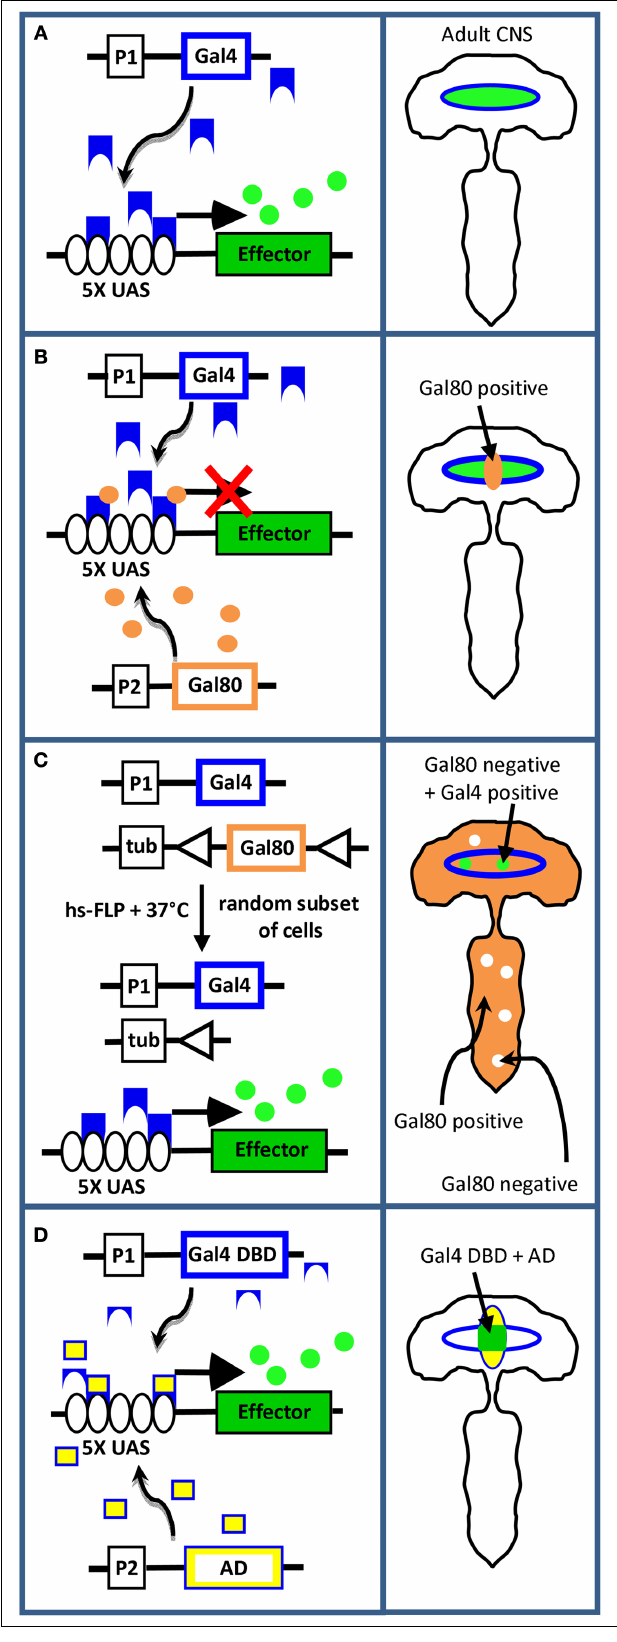
gene lies downstream of the promoter/enhancer element, P1, which dictates its pattern of expression. The effector transgene lies downstream of fi ve Gal4 binding sites (i.e. “UAS,” black ovals). In fl ies bearing both constructs, neurons that express Gal4 protein (blue shapes) also express the effector protein (green circles). Right panel: schematic of the fl y CNS depicting coincident expression of Gal4 (blue outline) and effector (green oval). (B) Subtractive restriction of effector gene expression using Gal80. Left panel: In cells that express the gene encoding Gal80 (brown outline) under the control of the promoter/enhancer P2, Gal80 protein (brown circles) will inhibit Gal4 by binding to its transcription activation domain and thus block effector gene expression (red X). Right panel: if P1 and P2 have overlapping expression patterns, Gal4 activity, and therefore effector expression, is eliminated in the region of overlap (i.e. in Gal80 positive cells, brown). (C) Random restriction using the “fl p-out Gal80” system. Left panel: if the Gal80 transgene is placed downstream of the ubiquitously active tubulin promoter (tub) and is fl anked by sites (triangles) that permit excision by heat-shock induced fl p-recombinase activity, the Gal80 gene will be deleted in random subsets of cells in animals subjected to heat shock. Only cells that express Gal4, but not Gal80, will also express the effector gene. Right panel: Effector expression (green) is limited to cells within the Gal4 expression pattern (blue outline) that lack Gal80 expression. (D) Combinatorial restriction using Split Gal4. Left panel: If the DNA-binding (blue, DBD) and transcription activation (yellow, AD) domains of the Gal4 molecule are independently targeted to different neuronal groups using promoters P1 and P2, Gal4 activity will be reconstituted and the effector transgene expressed only in cells at the intersection of the P1 (blue) and P2 (yellow) expression patterns, as depicted in the right